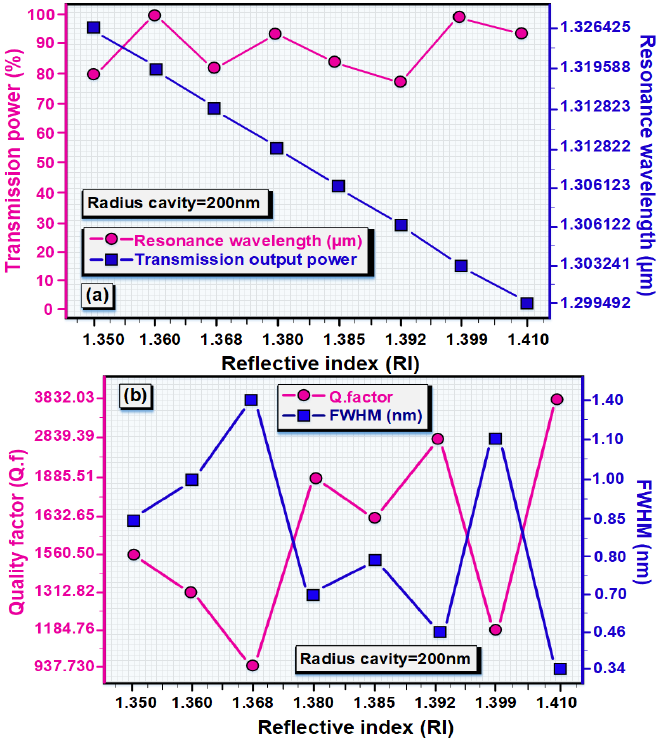
Figure 6. ( a ) Calculation of resonance wavelength parameters and transmission power efficiency for different refractive index. ( b ) Calculation of FWHM and Q factor parameters for different refractive index.